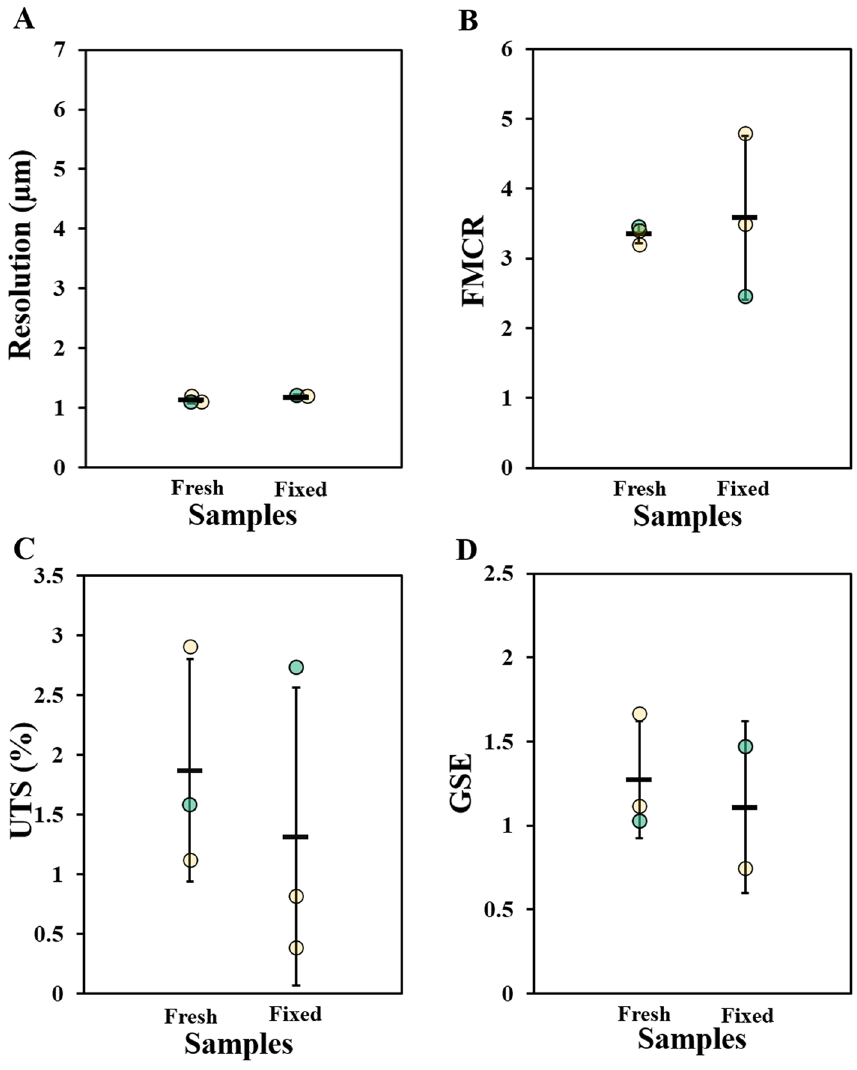
Figure 8. The image quality for the images acquired by HRM. The quality was determined by: ( A ) spatial resolution, ( B ) fiber to matrix contrast ratio (FMCR), ( C ) uncertainty of the threshold-based segmentation (UTS), ( D ) magnitude gradient sharpness at the edges (GSE), in this group n = 2 due to fact that in one sample no fat cells were visible in the FOV. Individual sample measurements are shown as circles, mean and standard deviation for each group are indicated. Fresh = fresh frozen samples in PBS and fixed = fixed samples in ethanol. Samples imaged with both microscopes are highlighted in